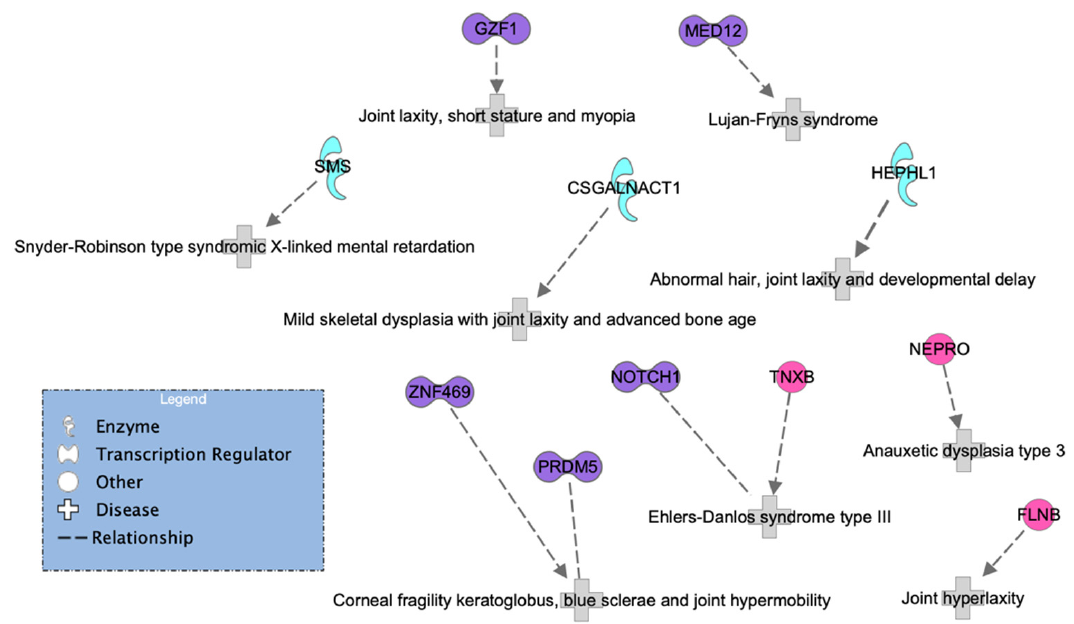
Figure 6. HSD network of genes known to be associated with HS according to the IPA database. No matches were found in a more specific search, including type III (or type 3), which is hEDS. However, we can see from the network that the transcription regulator NOTCH1,